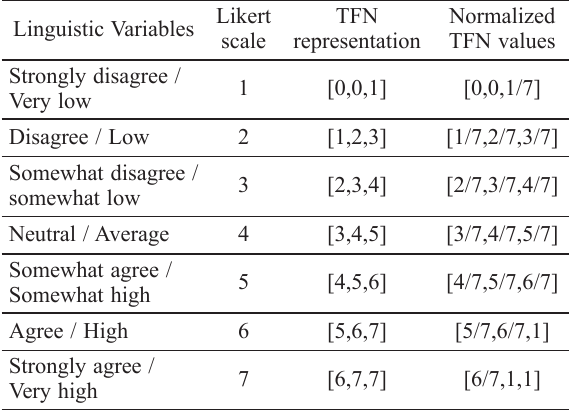
Table 2. Description of Likert scale and assumption of fuzzy